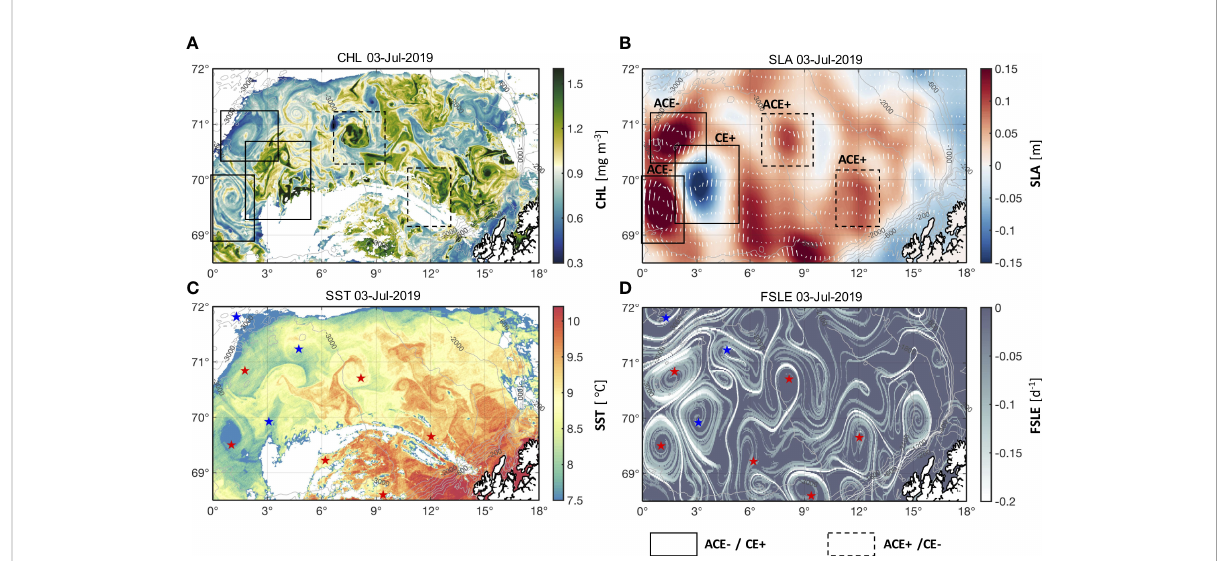
FIGURE 3 Spatial distribution of (A) CHL, (B) SLA, (C) sea surface temperature (SST), and (D) Finite-size Lyapunov Exponent (FSLE) for 3 July 2019. ACE- and CE+ in (A, B) are demarcated by solid boxes; ACE+ and CE- in (A, B) are demarcated by dashed boxes. ACEs and CEs in (C, D) are indicated by red and blue stars, respectively.